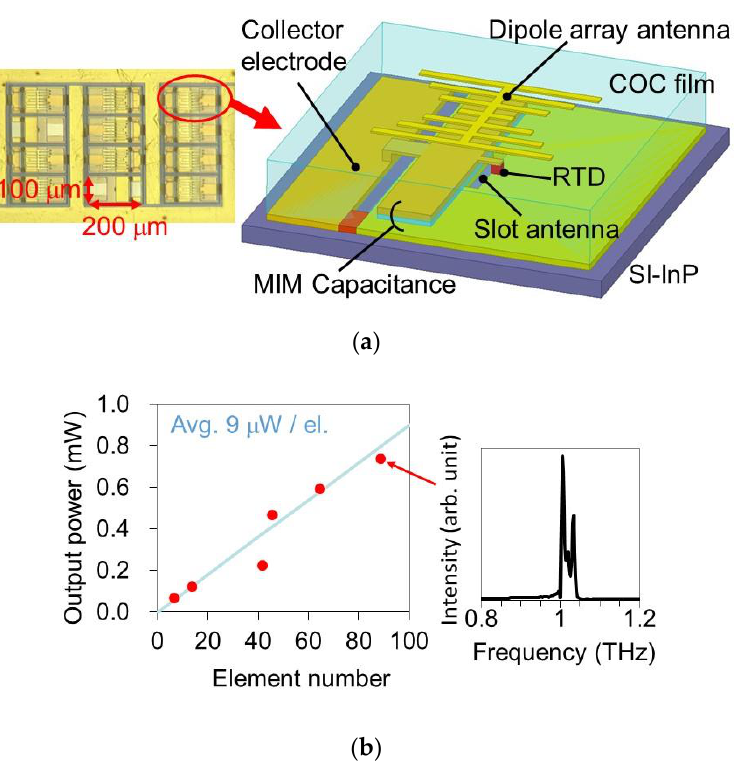
Figure 5. Large-scale array of RTD oscillators. Reprinted from Reference [63] with the permission of AIP Publishing: ( a ) Structure of the device—an array element is composed of an RTD with a slot antenna (resonator) covered by COC (cyclic olefin copolymer) film and a dipole array antenna (radiator), and ( b ) output power as a function of element number and oscillation spectrum for 89-element array.